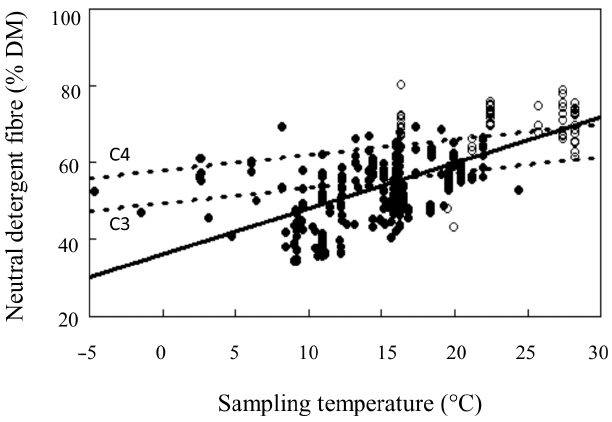
Figure 2. The linear relationship between forage-neutral detergent fibre (NDF) content and temperature ( ◦ C) at the time of sam- pling. The filled circles are C3 species and the open circles are C4 species ( P< 0 . 05). The dotted lines represent best fit lines for C3 (NDF = 0.4T + 49) and C4 species (NDF = 0.4T + 58). The contin- uous line represents the best fit line for all species excluding other factors included within the LME model (NDF = 1.1T + 36).